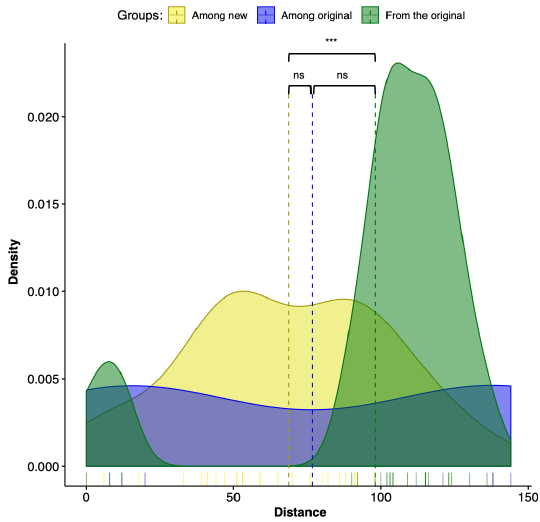
Figure 7. Density plot representing the distribution of the match-split distances among unrooted binary cladograms. The Kruskal–Wallis test was significant ( p = 0.0048) only between groups “among new” and “from the original.” Dashed lines represent the mean of the